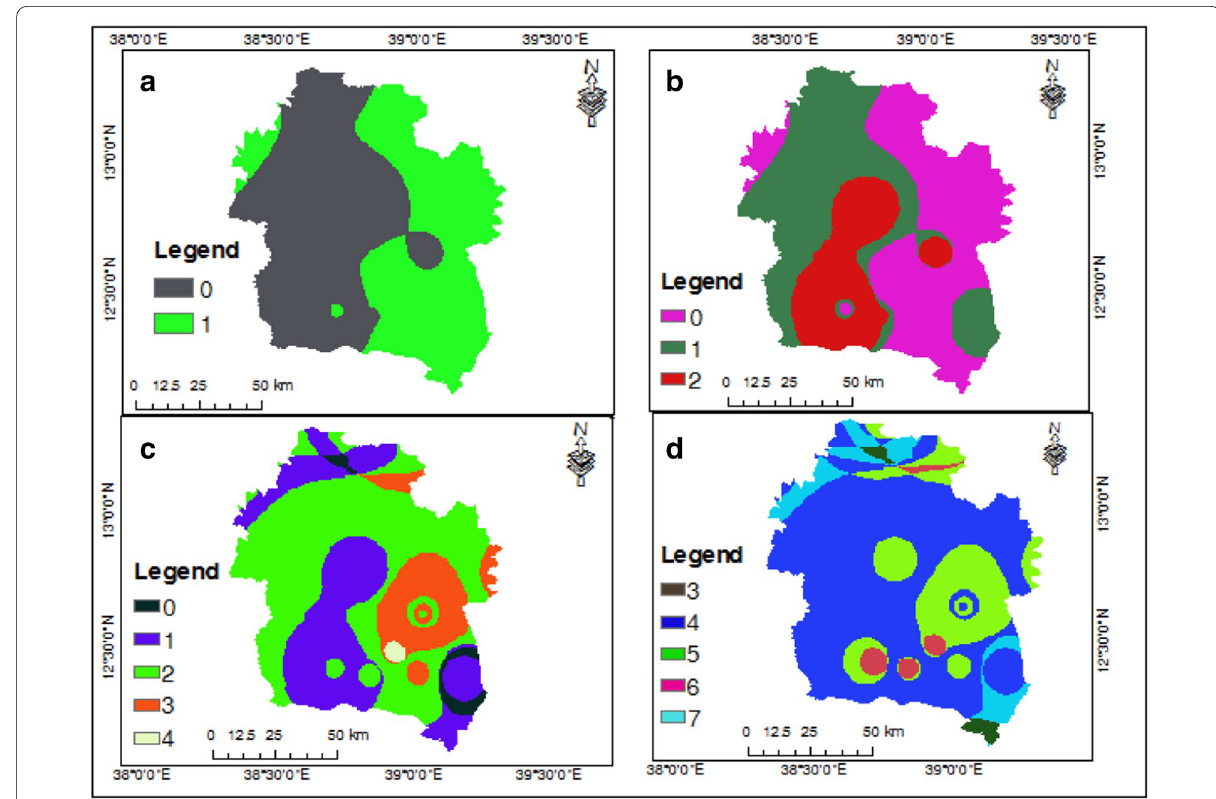
Fig. 16 Frequency (year) of metrological drought risk in four different severity classes: a very severe, b severe, c moderate and d